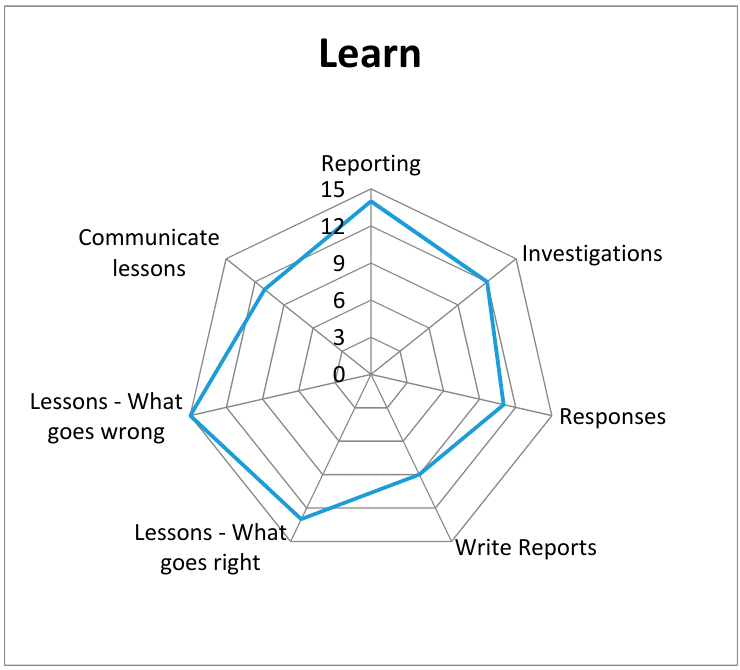
Figure 3. Potential to Learn—Yes responses.